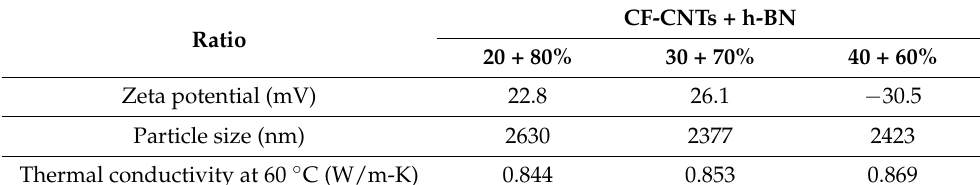
Table 1. Details of the samples with different ratios of hybrid nanofluid following preparation.